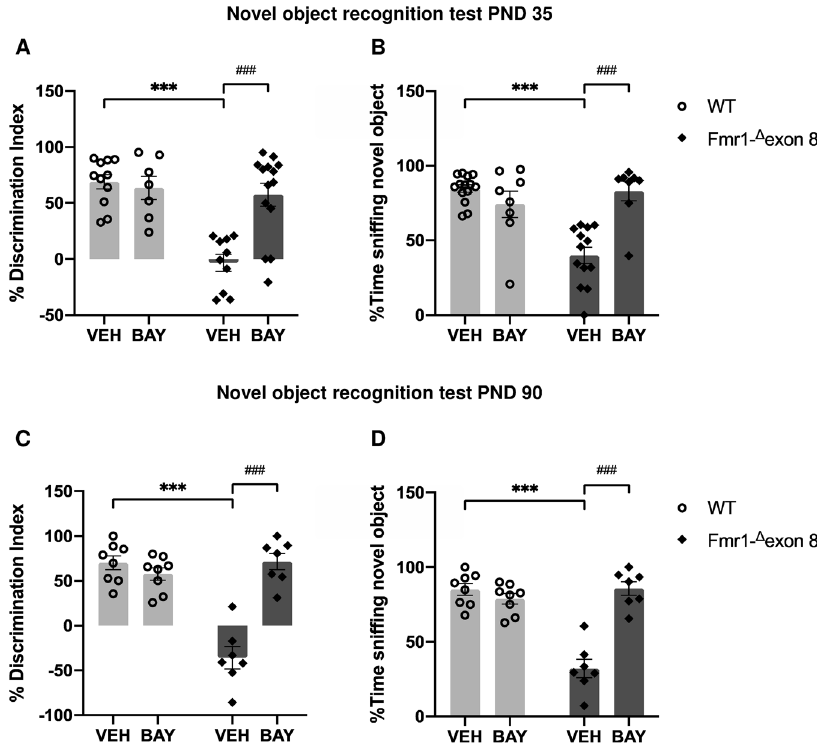
Fig. 3 Pharmacological inhibition of PDE2A normalizes the cognitive de fi cits displayed by Fmr1- Δ exon 8 rats in the course of development. Juvenile and adult Fmr1- Δ exon 8 rats show a reduced discrimination index ( A , C ) and spend less time snif fi ng the novel object ( B , D ) in the novel object recognition test. Both these parameters are normalized when Fmr1- Δ exon 8 rats are treated with BAY607550 (PND 35: WT-VEH, n = 11; WT-BAY, n = 7; KO-VEH, n = 10; KO-BAY, n = 14; PND 90: WT-VEH, n = 8; WT-BAY, n = 8; KO-VEH, n = 7; KO-BAY, n = 7). Data represent mean ± S.E.M. *** p < 0.001 vs WT-VEH group, ### p < 0.001 vs Fmr1- Δ exon 8 -VEH group (Student ’ s – Newman – Keuls post hoc